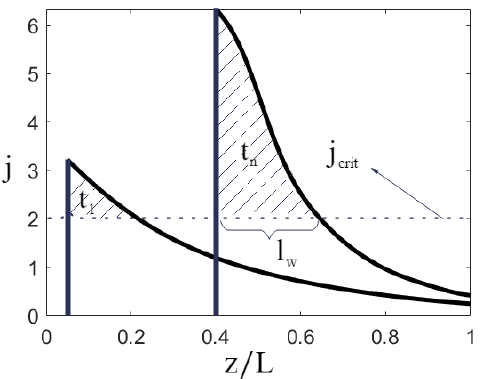
Figure 8. A schematic of the degradation wave to better clarify the concept of critical current density. The dashed area represents the critical conditions, under which degradation occurs. Assuming z w (t) (cm) as the position of the degradation wave, ( L − z w ) is the length